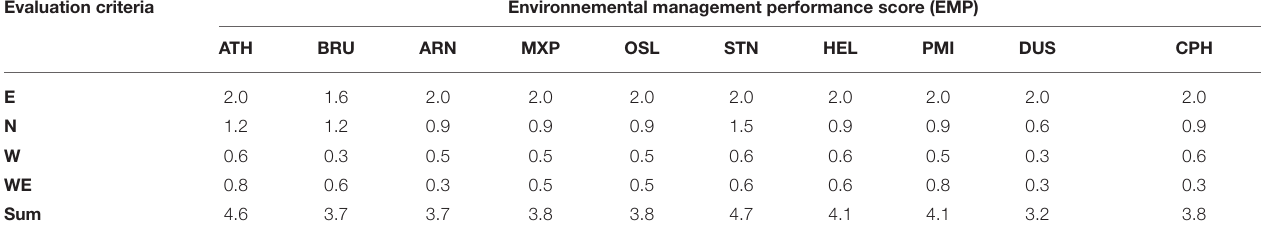
TABLE 4 | Airports’ environmental management performance scores. Evaluation criteria